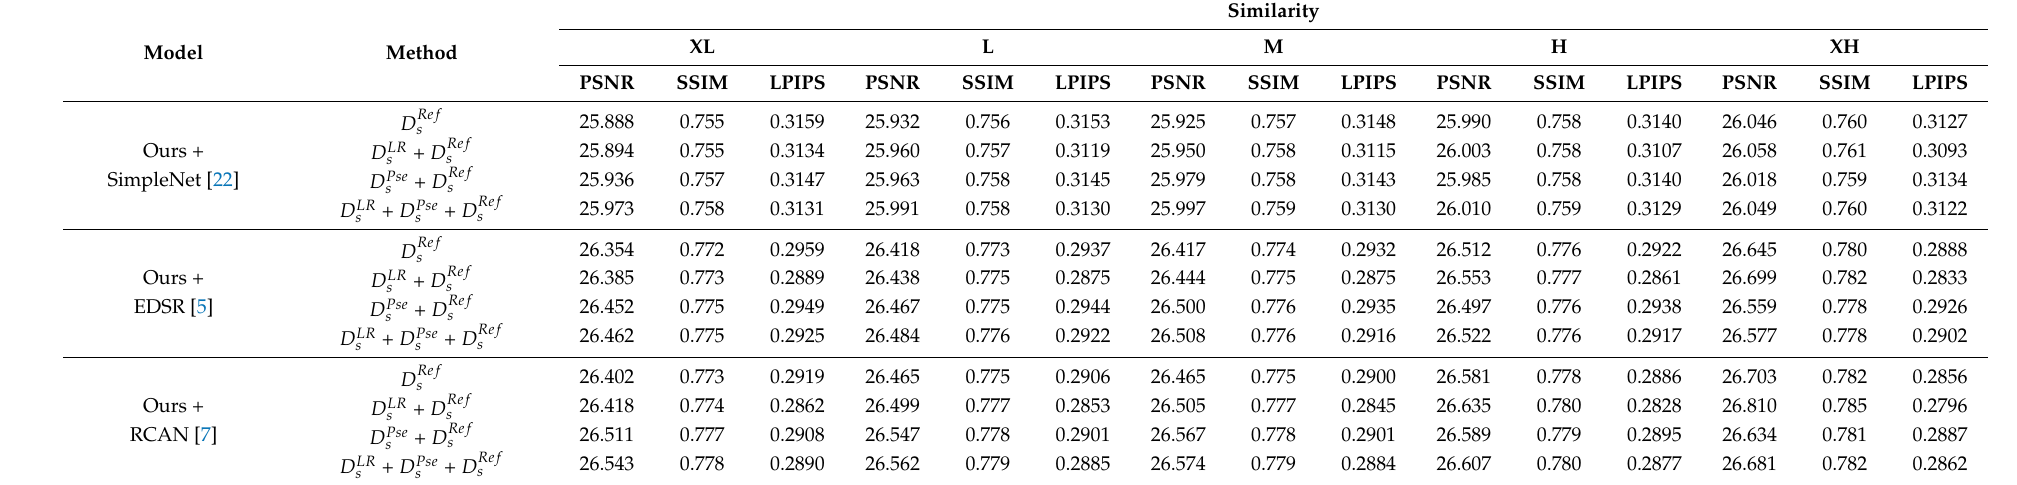
Table 3. RefSR online learning results on SISR